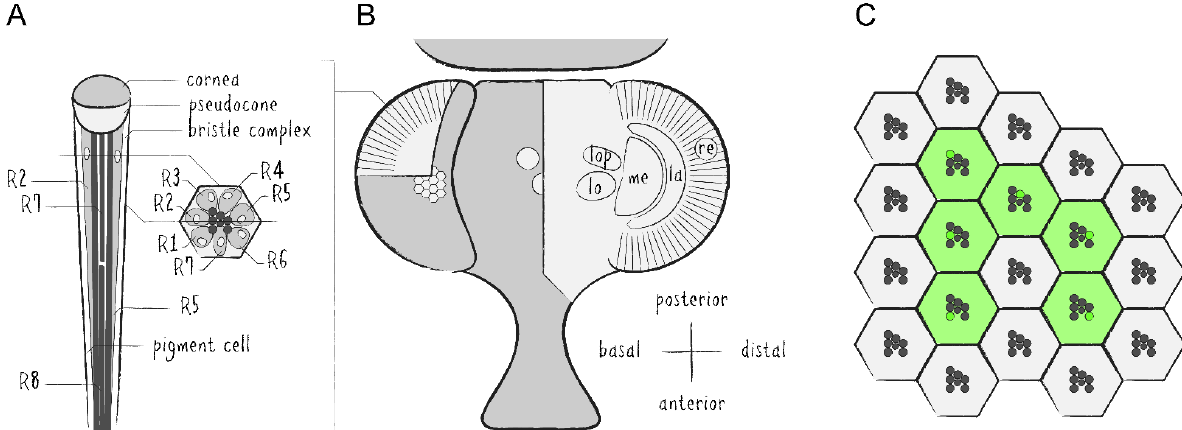
Figure 1. Schematics of the Drosophila visual system. ( A ) Illustration of a longitudinal section through the ommatidial center (left side) and a cross section through the plane just below the pseudocone, where the nuclei (white) of the photoreceptor cells (PRCs) R1–7 (light grey) are located (right side). Trapezoidal layout of the outer PRCs’ rhabdomeres in the center of the ommatidium is indicated (dark grey). Primary and secondary pigment cells not drawn. ( B ) Top view of a partially cross sectioned Drosophila head to illustrate the organization of the ommatidia (left side) and the optic lobe (right side). Indication of the hexagonal tiling by individual corneas on the curved surface of the compound eye and partial cross section to illustrate the wedged shape of ommatidial units. Order of neuropils from distal to basal: retina (re), lamina (la), medulla (me), lobula (lo) and lobula plate (lop). ( C ) Illustration of the repetitive organization and identical orientation of ommatidia and PRCs in a top view of a section of the compound eye. Origin of the pseudopupil phenomenon is indicated by highlighting the fluorescence of individual rhabdomeres from adjacent ommatidia (green) which together generate the fluorescent ommatidial trapezoid when rhabdomeral FPs are expressed in R1 – 6.